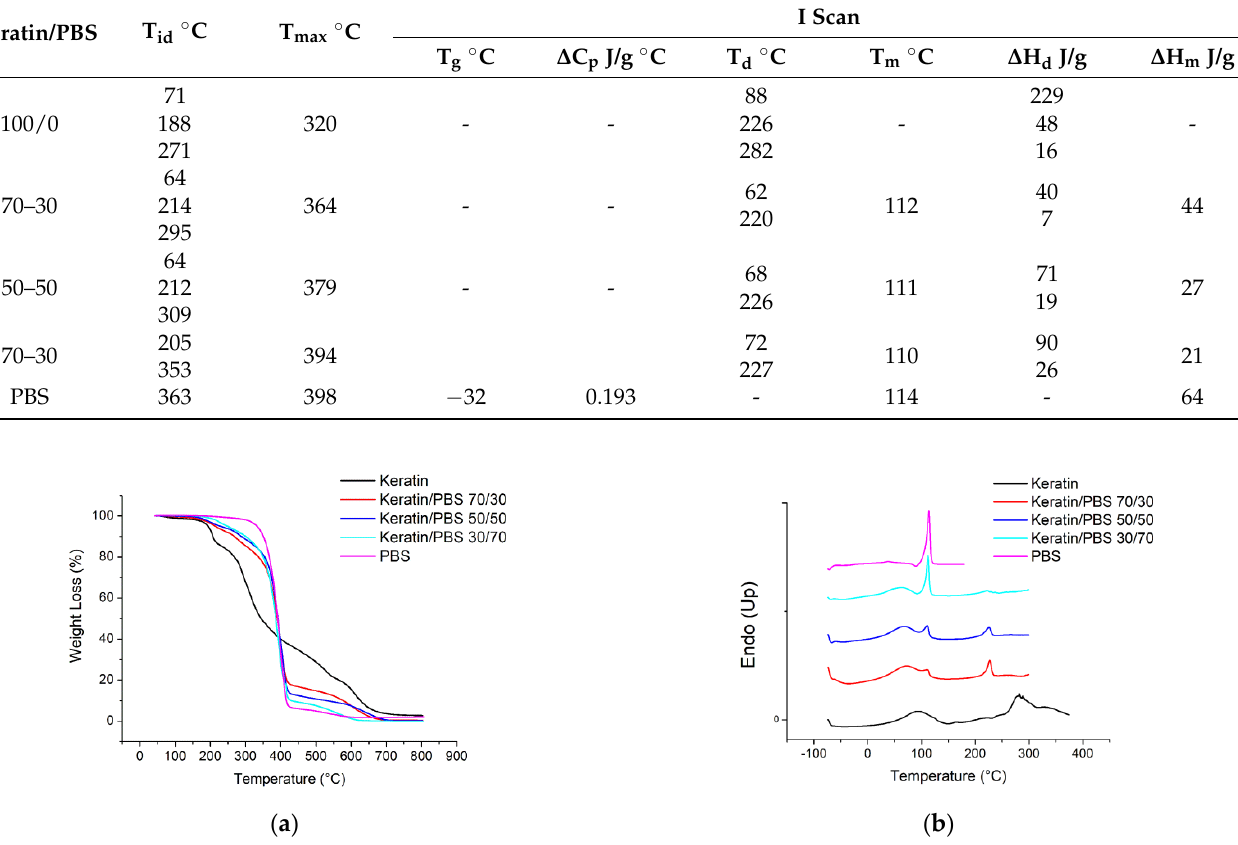
Table 3. Thermal characterization data (TGA and DSC) of PBS, keratin and Keratin/PBS blend electrospun mats. Keratin/PBS